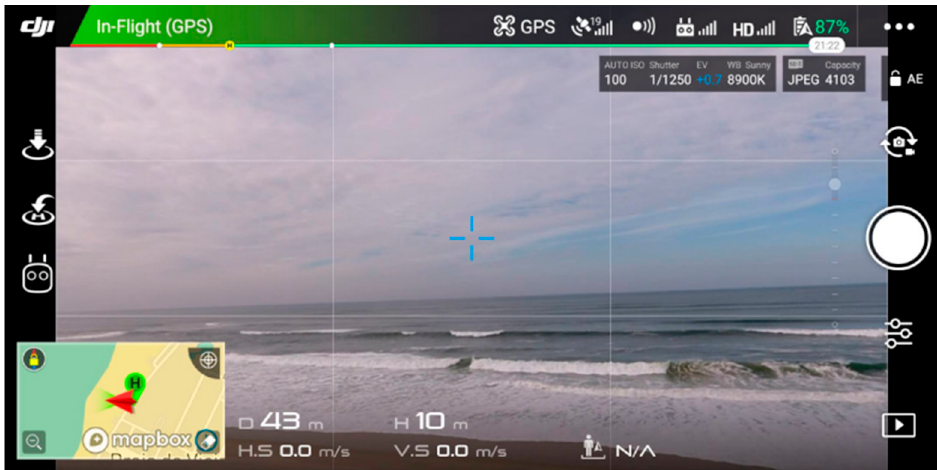
Figure 2. Screenshot of the DJI Go app that works as a mobile Ground Control Station during the flight of a Phantom 4.